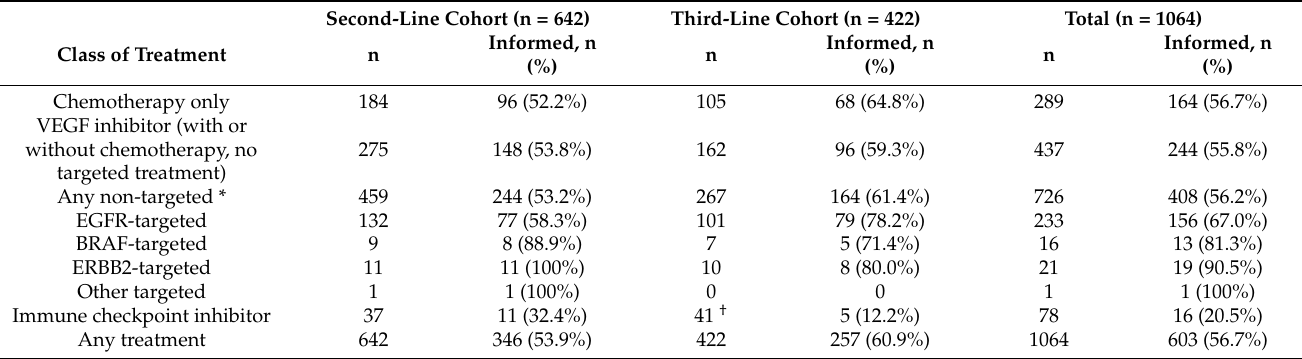
Table 3. Systemic treatments after ctDNA